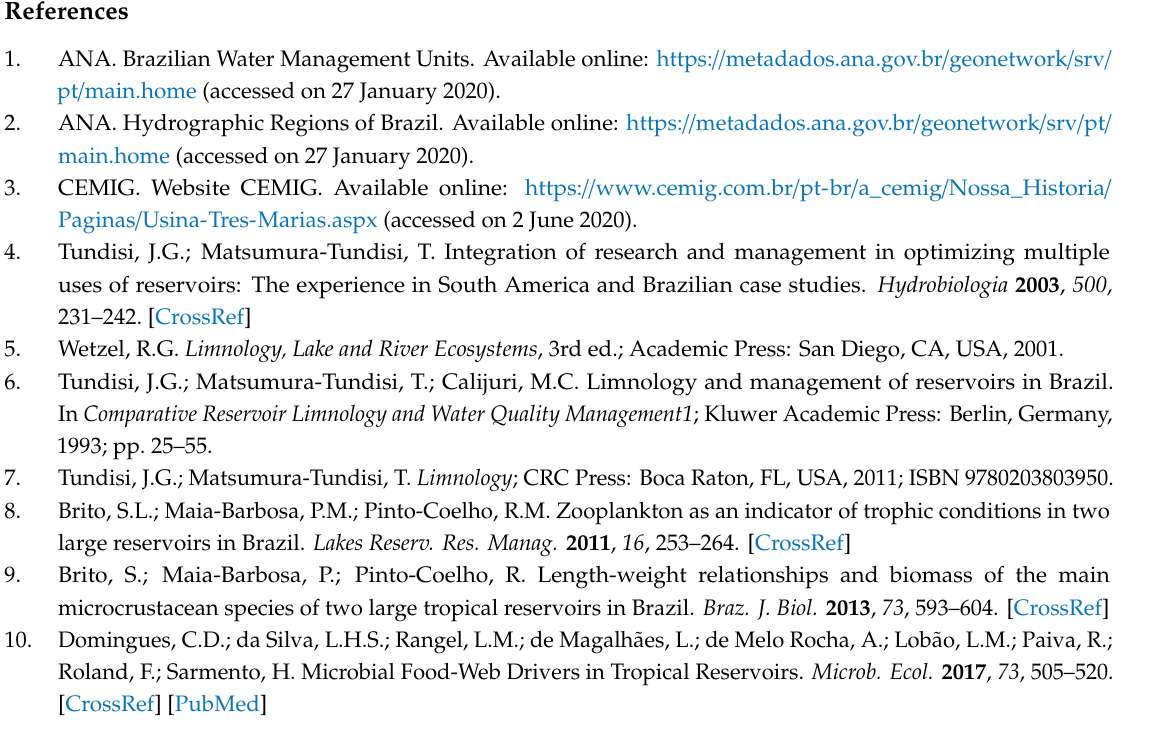
Figure S1: K d − SA ( λ ) derived from MSI bands R rs ( λ ) validations for QAAv6 at: (a) 443; (b) 492; (c) 560; and, (d) 665